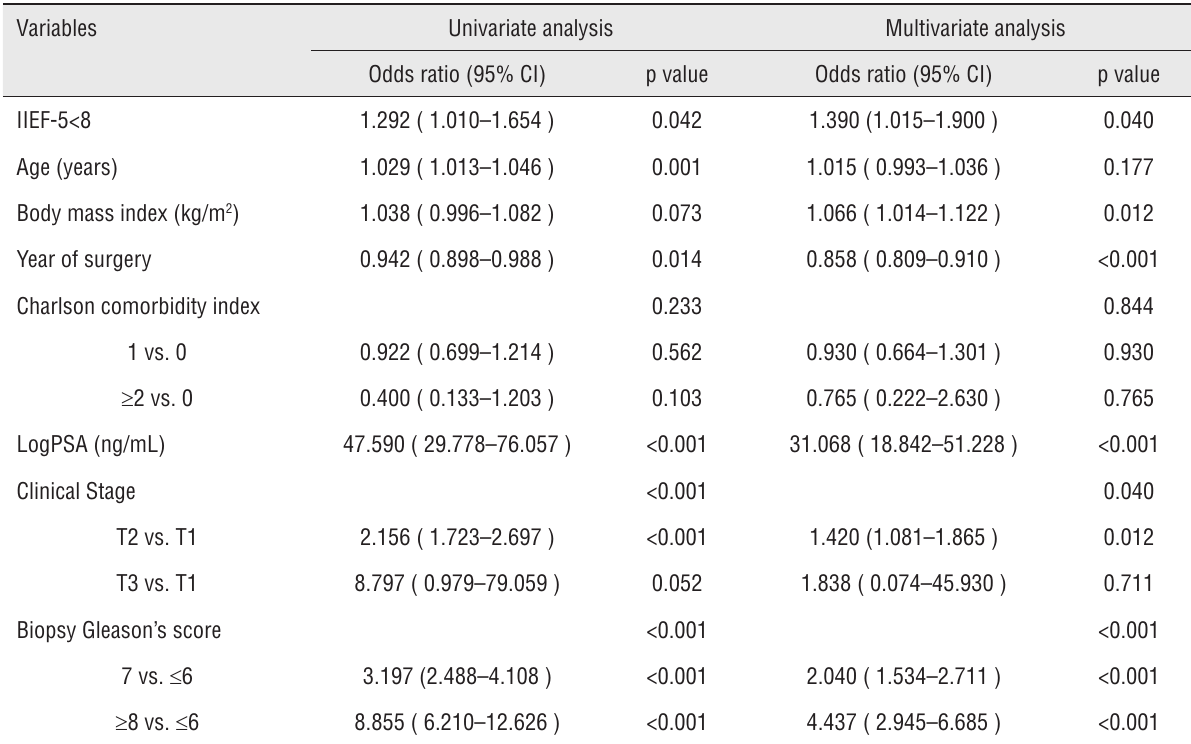
Table-3 - Univariate and multivariate logistic regression analysis to larger tumor volume (>5 mL).